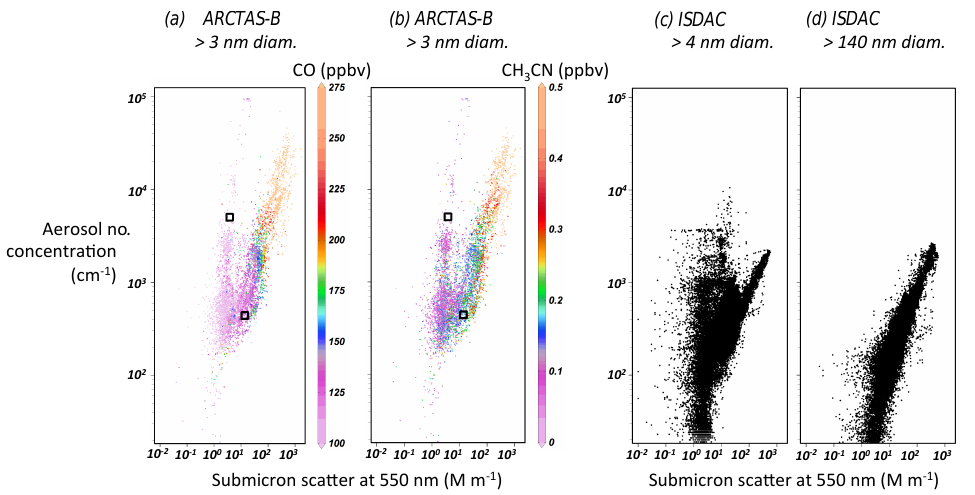
Figure 9. Log relationships between ARCTAS-B and ISDAC aerosol number concentration and submicron scatter. In panels (a) and (b) , the combustion tracer, CO, and the biomass burning tracer, CH 3 CN, are also shown in out-of-cloud air masses. The black squares in panels (a) and (b) indicate where background aerosol concentrations of 5000cm − 3 and dilute smoke concentrations of 450cm − 3 would be relative to other points. Measurements are from the following instruments: (a) and (b) TSI 3025, (c) TSI 3775, and (d) PCASP. ARCTAS-B summertime samples were taken at altitudes < 5.2km; ISDAC samples were taken at < 3.65km due to TSI3025 instrument limitations. All quality- flagged data were excluded, as well as suspicious ISDAC values within 17km and < 1km altitude of Fairbanks airport, Alaska. Very small background aerosols appear to dominate the high aerosol number concentration/low scatter particles seen in (a) – (c) , as shown by their disappearance when a diameter cutoff of 140nm is used (d)